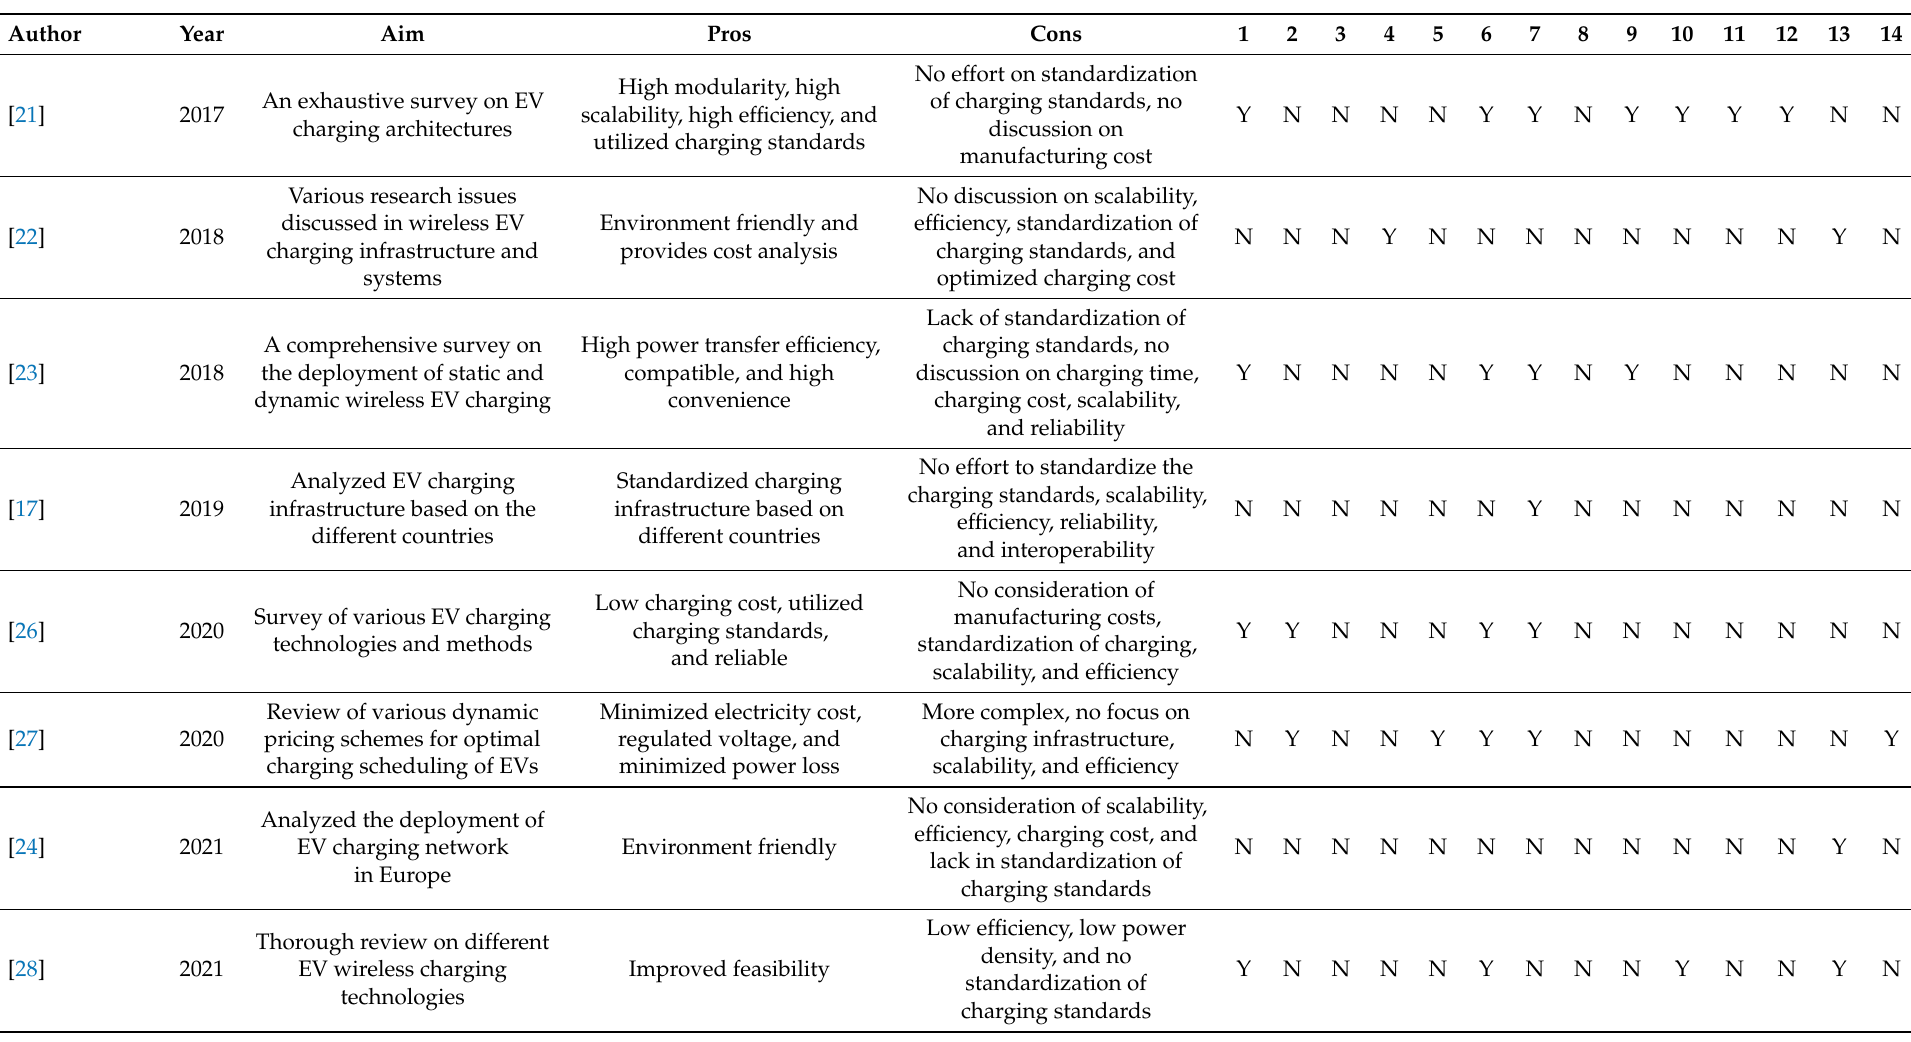
Table 1. Comparative analysis of various state-of-the-art surveys with the proposed